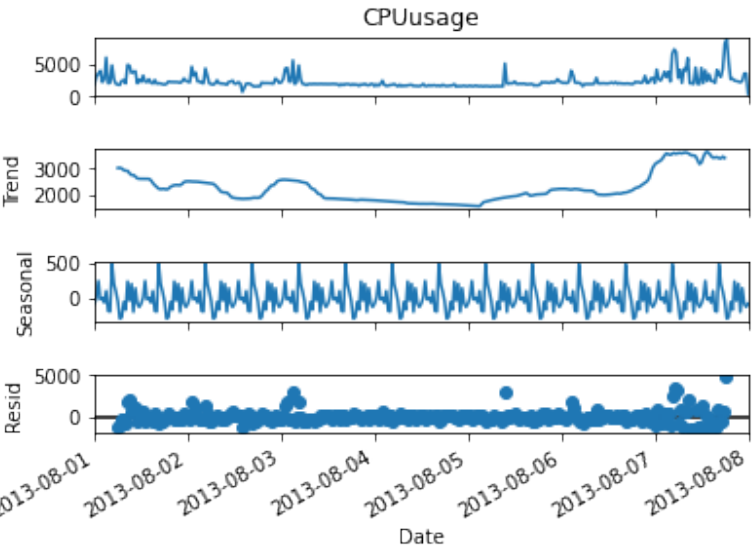
Figure 3. Analysis of trend and seasonal components of CPU